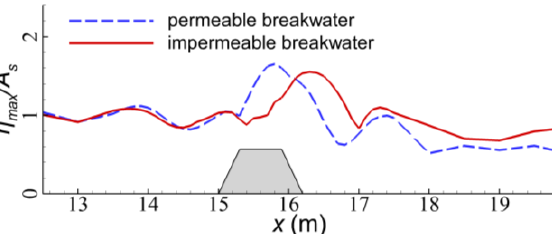
Figure 9. Space – time plots of the water surface elevations of the focused wave groups over the sub- merged breakwaters; left side : submerged impermeable breakwater; right side : submerged perme- able breakwater; dash-dot line: breakwater region.